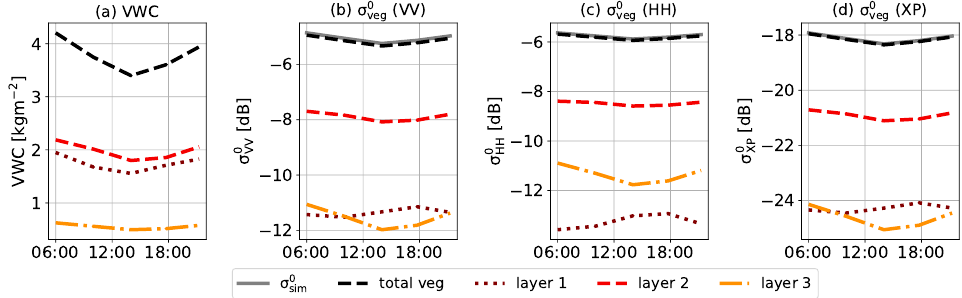
Figure 11. Diurnal VWC estimates for 25 July 2019 separated by layer ( a ); and the corresponding diurnal variations in the layer contributions to total vegetation scattering ( σ 0 veg ), simulated by the water cloud model and separated by VV ( b ); HH ( c ); and cross-polarization ( d